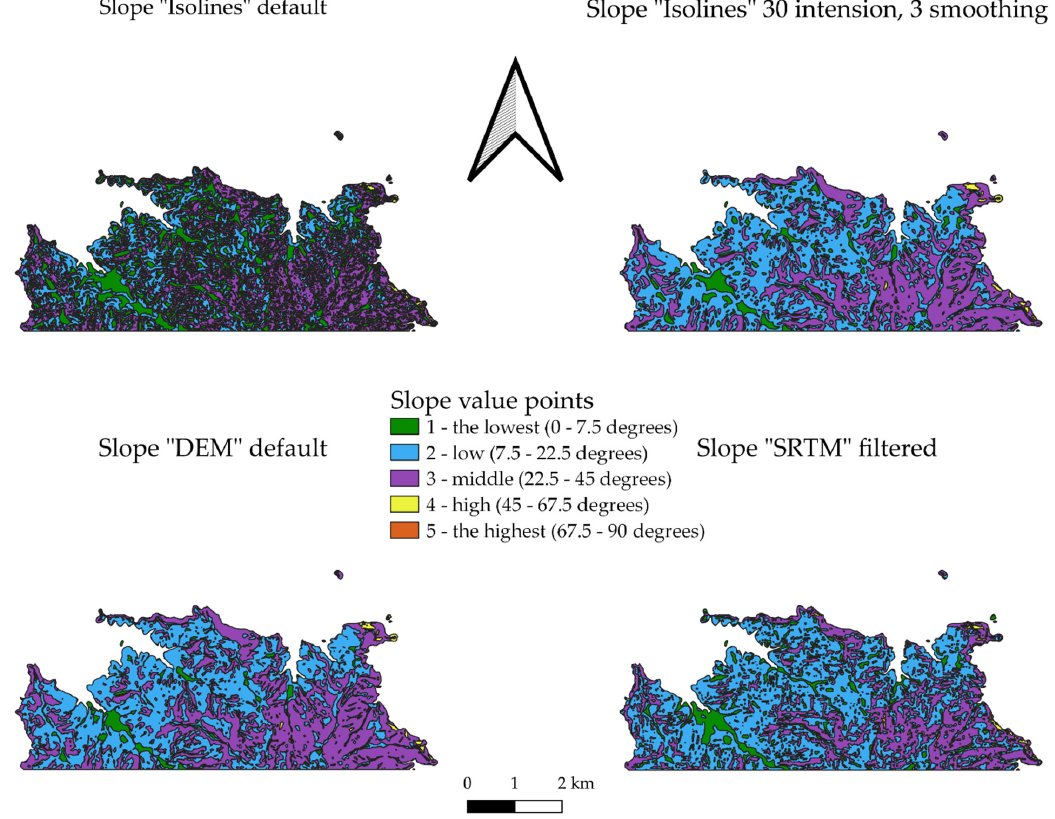
Figure 5. Slope polygon vector models of the Port Jackson, Fletcher Bay, and Port Charles districts in Coromandel Penin- sula.